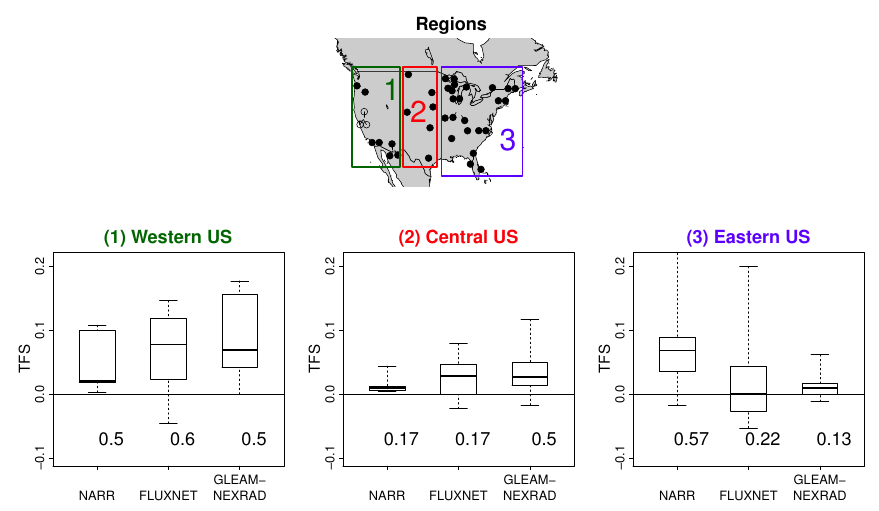
Figure 3. Quantitative comparison of the triggering feedback strength (TFS ∗ ) in different regions for the three data sets shown in Fig. 2. (top) Definition of the regions. (bottom) Box plot of TFS ∗ in the three regions, where numbers below boxes indicate the fraction of sites with significant TFS ∗ . Central lines denote medians, boxes show interquartile ranges, and whiskers denote minimum and maximum values. Empty dots on the map indicate sites with unreliable NEXRAD data and which are excluded from the box plot.